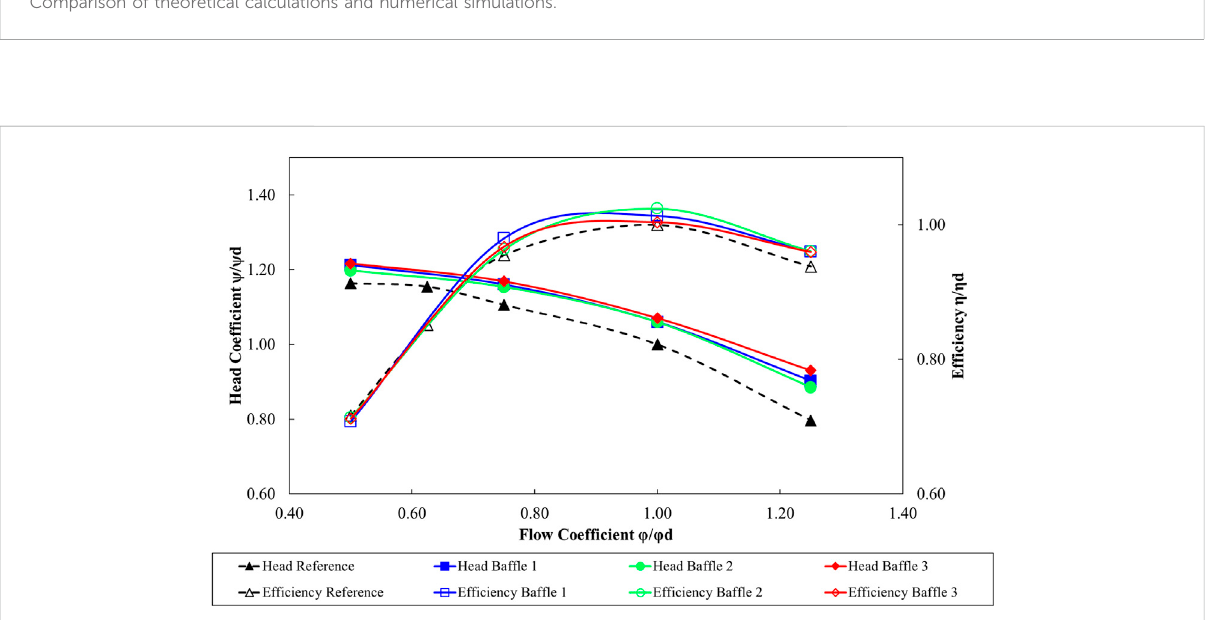
FIGURE 5 Performance comparison of different baf fl e designs with the reference